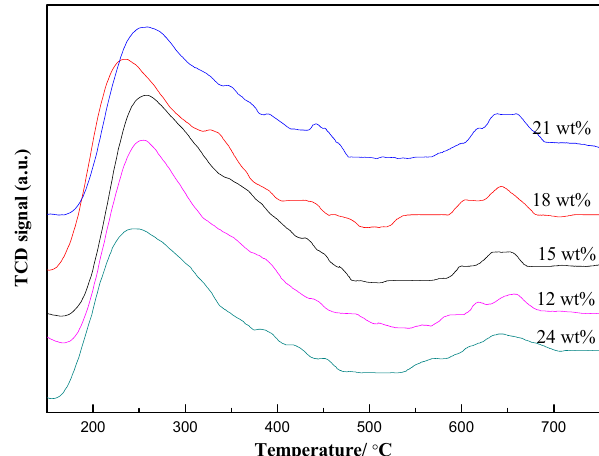
Figure 5. NH 3 -TPD curves of the Cr-Pt/WZ catalyst with different WO 3 contents.